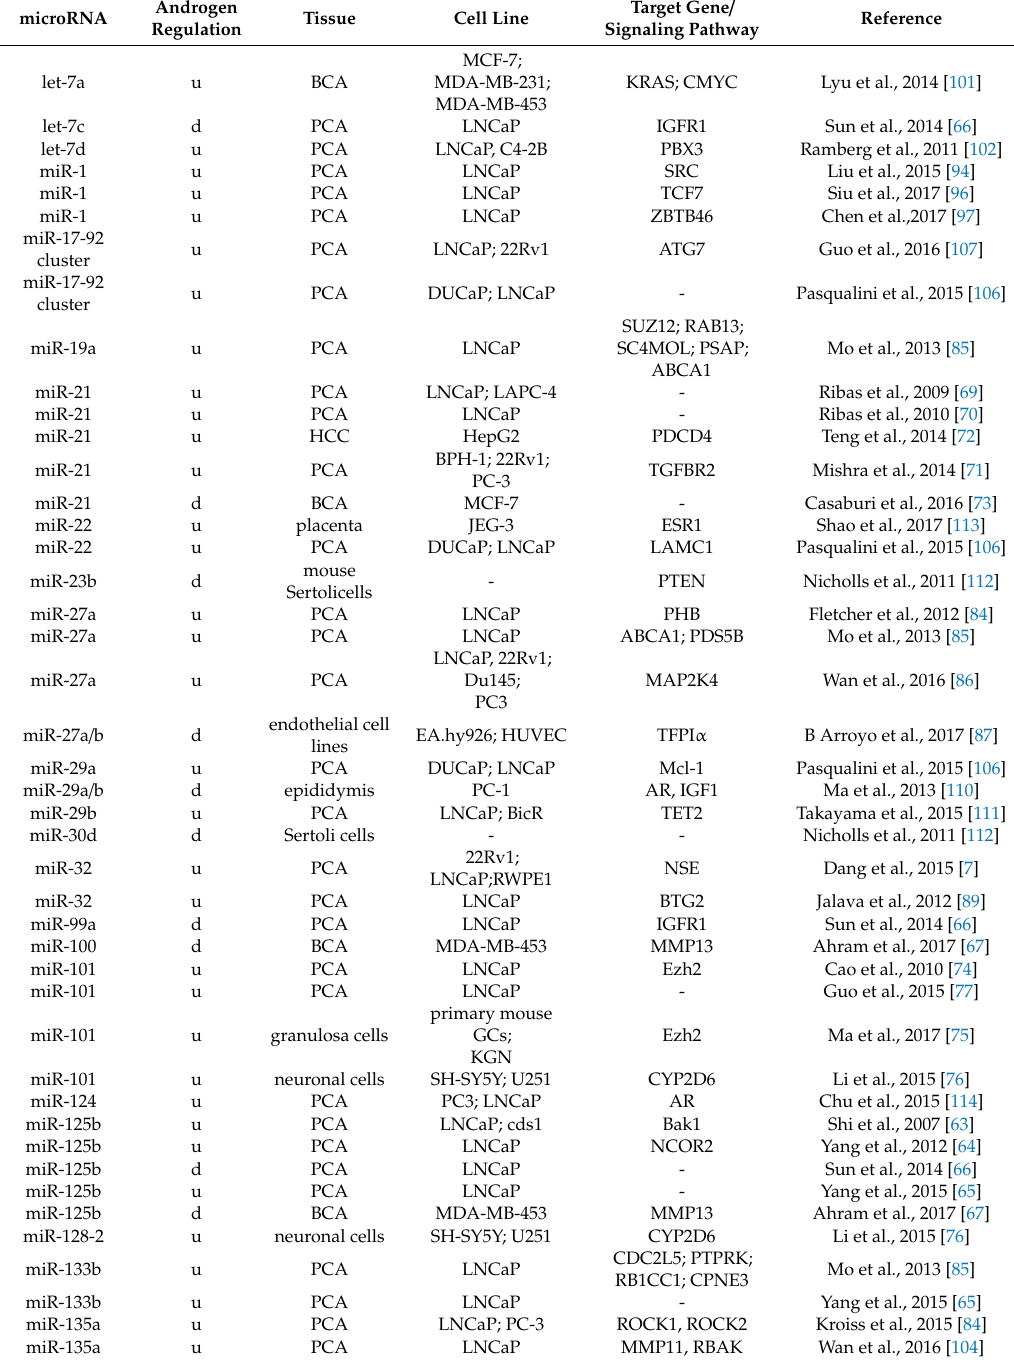
Table 2. Androgen-regulated microRNAs